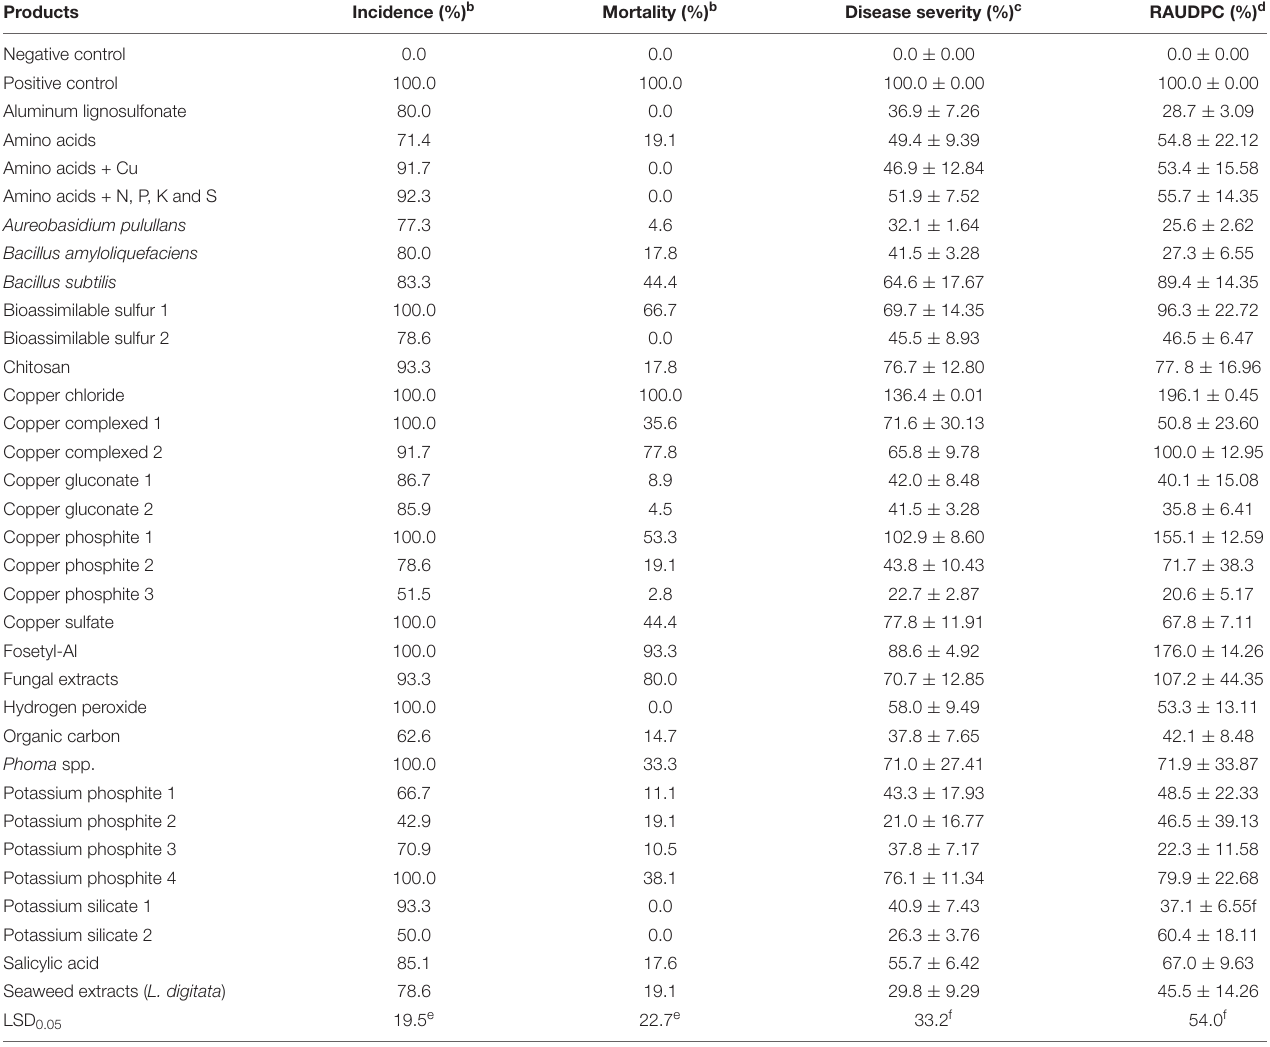
TABLE 5 | Disease-related parameters for olive plants grown in artificially infested substrate with the defoliating Verticillium dahliae isolate V180 and treated with the evaluated products by irrigation a